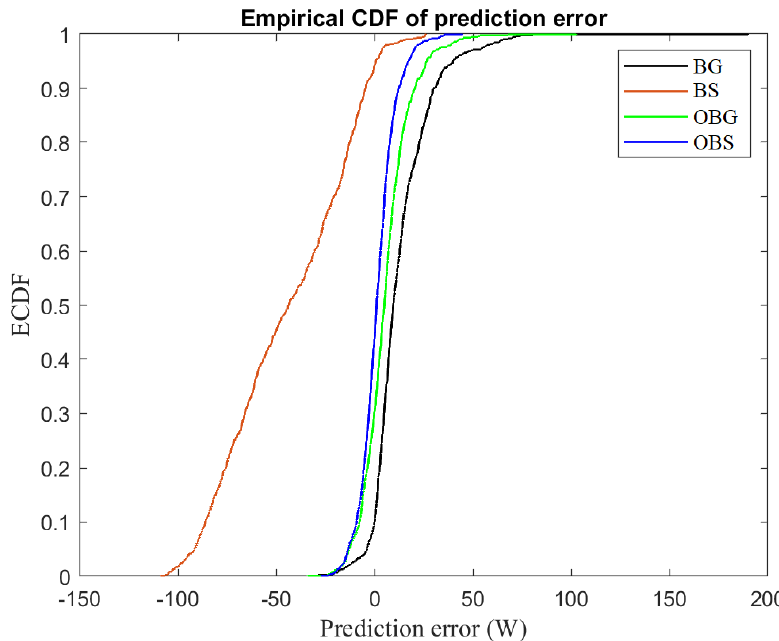
Figure 9. Empirical CDF of the prediction errors for the invstigated models.